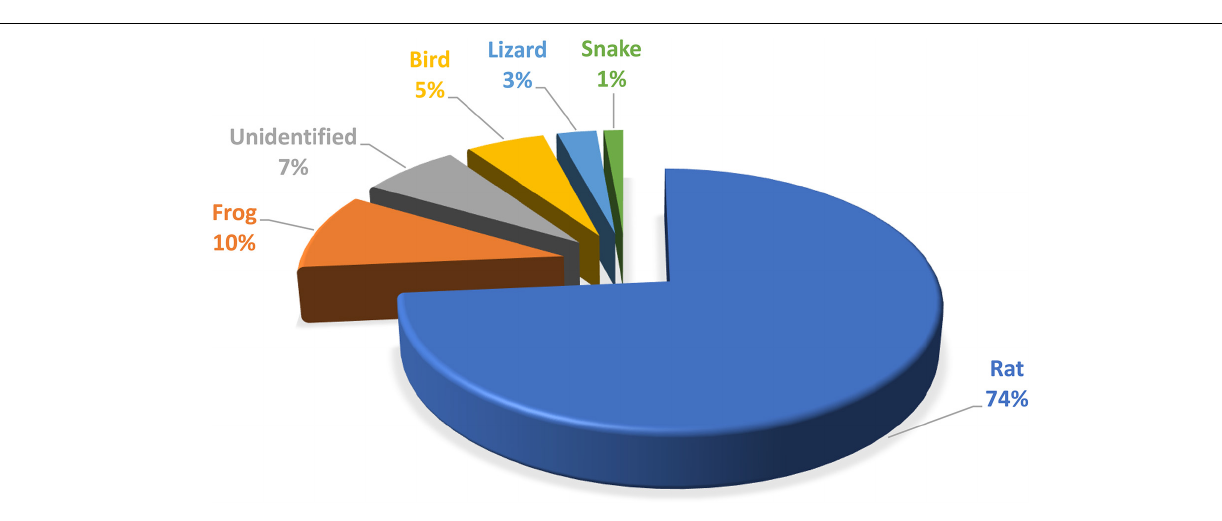
FIGURE 5 | Leopard cat dietary composition recorded during radio-tracking the study